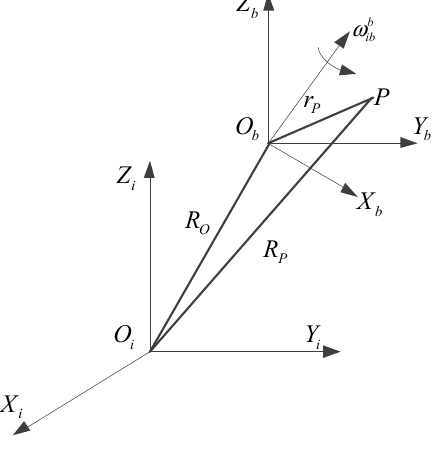
Figure 3. Schematic diagram of lever arm effect.